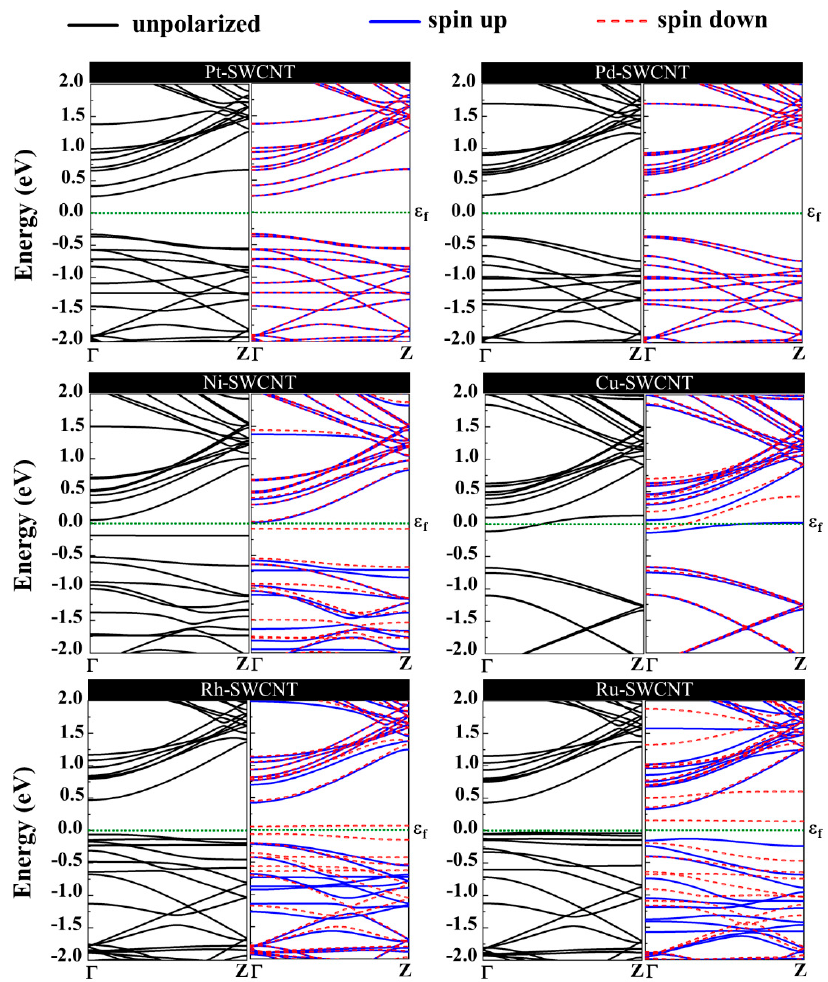
Figure 5. Energy band structures of Pt-SWCNT, Pd-SWCNT, Ni-SWCNT, Cu-SWCNT, Rh-SWCNT, and Ru-SWCNT systems. The dotted green line indicates the Fermi level, which is set to zero.